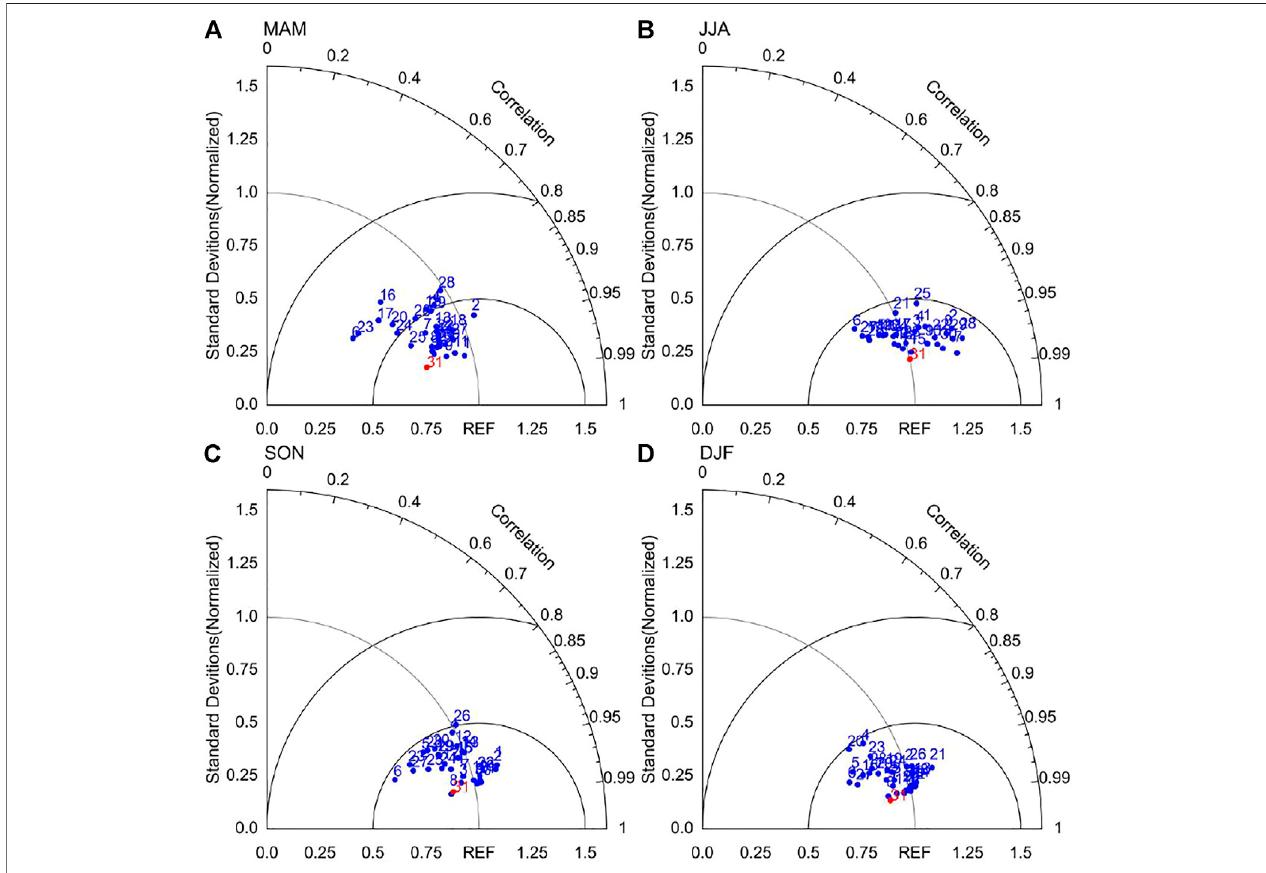
FIGURE 1 | Taylor diagram of (A) spring, (B) summer, (C) autumn and (D) winter UTT over the Asian-Paci fi c sector during 1965 – 2014. Numbers 1 – 30 represent the individual models (see Table 1 for which model each number indicates). Number 31 represents MME. REF indicates the NCEP/NCAR reanalysis and acts as the reference